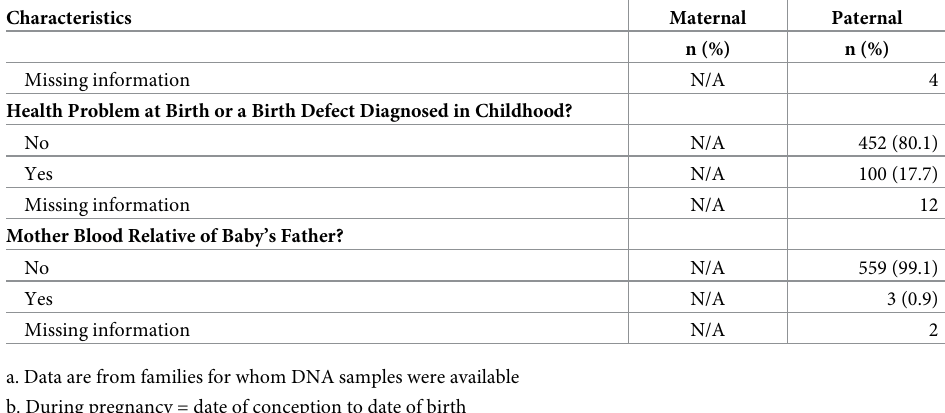
a. Data are from families for whom DNA samples were available